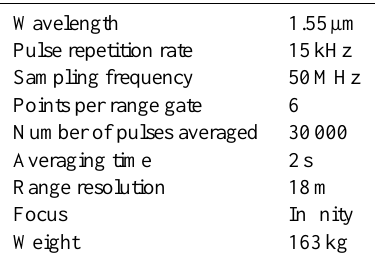
Table 1. System parameters of the HALO Doppler